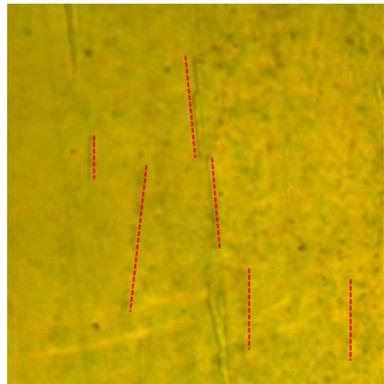
Optical texture (magnification 150X) of planar aligned 5CB + 0.5 wt% CuO NPs sample. Red dotted lines are added to the texture to guide to eyes to indicate linear strings of CuO NPs. Note that some NPs are spread as individual as well. (For interpretation of the references to colour in this figure legend, the reader is referred to the web version of this article.)